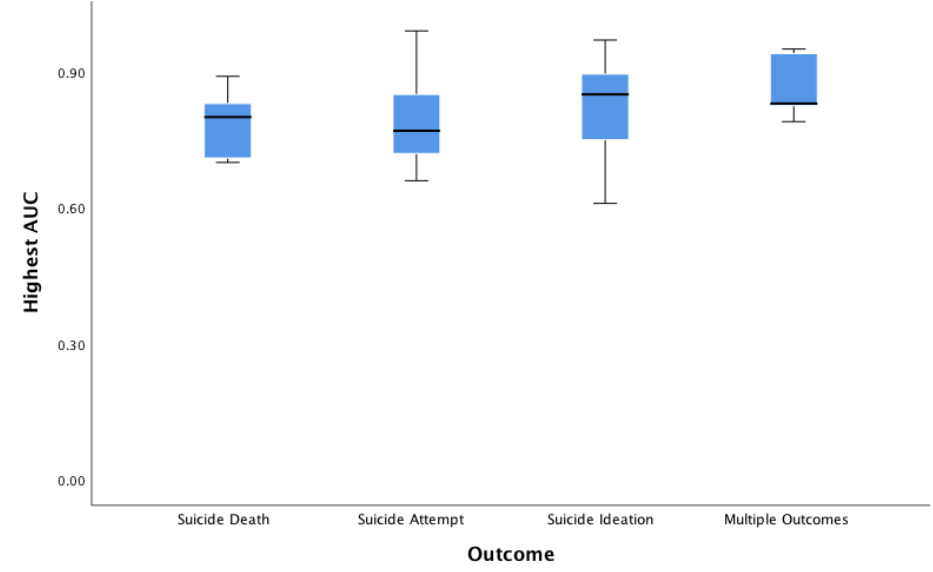
Figure 3. Boxplot of AUC by suicide outcome. Boxplot of classification area under the curve (AUC) by